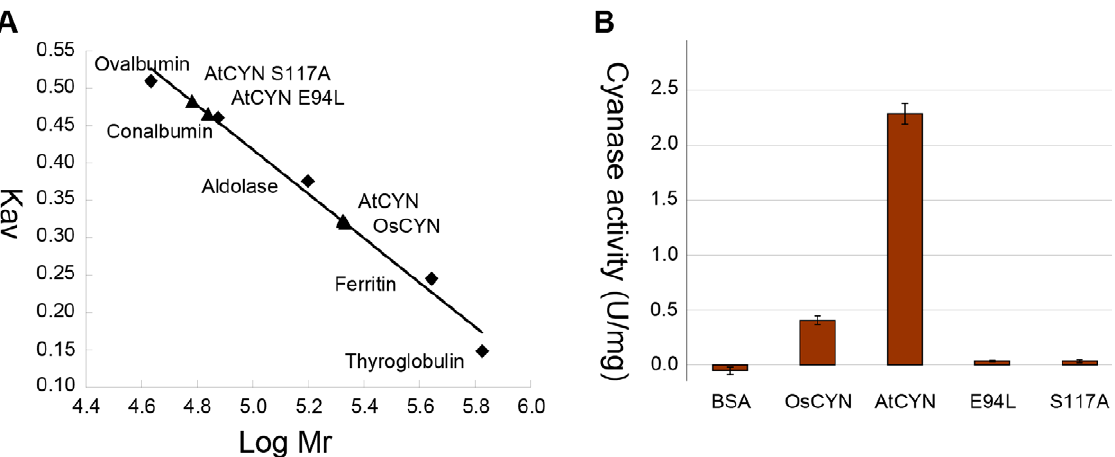
Figure 8. Gel filtration and cyanase activities of His-tagged AtCYN, OsCYN and AtCYN mutants (E94L and S117A). (A) Gel filtration. High Molecular Weight (HMW) Standard: Thyroglobulin, 669 kDa; Ferritin, 440 kDa; Aldolase, 158 kDa; Conalbumin, 75 kDa and Ovalbumin, 43 kDa. And calculated molecular weight: AtCYN, 210.74 kDa; OsCYN, 211.72 kDa; AtCYN-E94L, 71.64 kDa and AtCYN-S117A, 62.76 kDa. (B) Cyanase activities of His-tagged AtCYN, OsCYN and AtCYN mutants (E94L and S117A) at pH 7.7 and 27 u C.